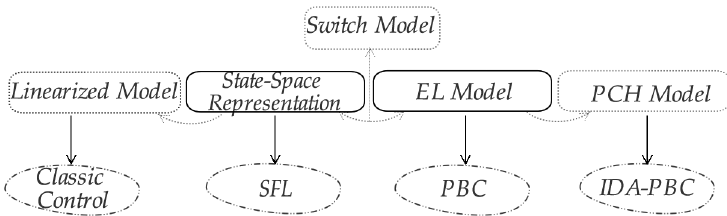
Figure 3. Models associated with non-linear control